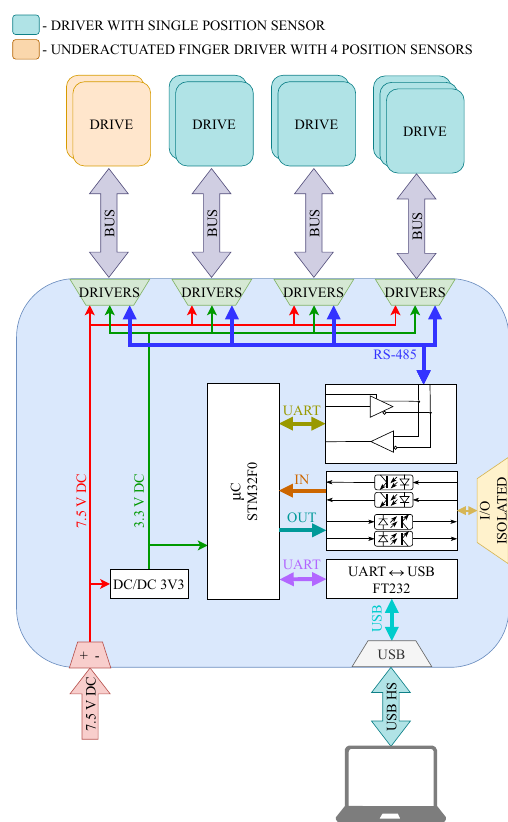
Figure 9. PUT-Hand low-level controller architecture, with DRIVER modules connected in star pattern allowing easy interchangeability of components; main unit (HUB) diagram showing circuit components.